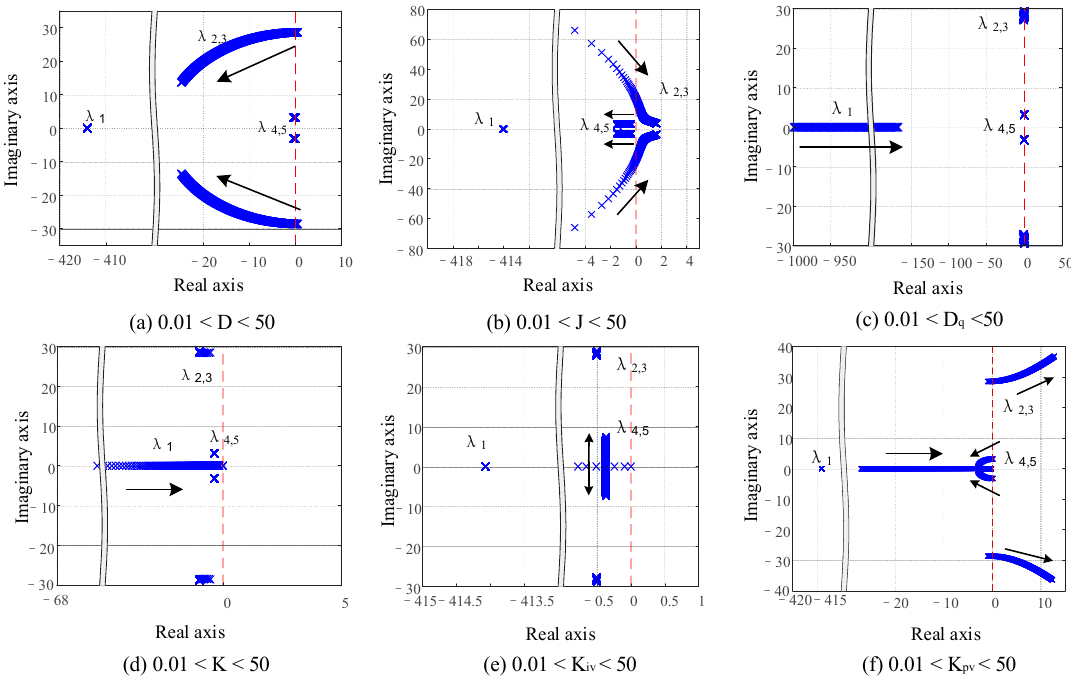
Figure 4. The eigenvalue locus plot under different combinations of controller parameters.